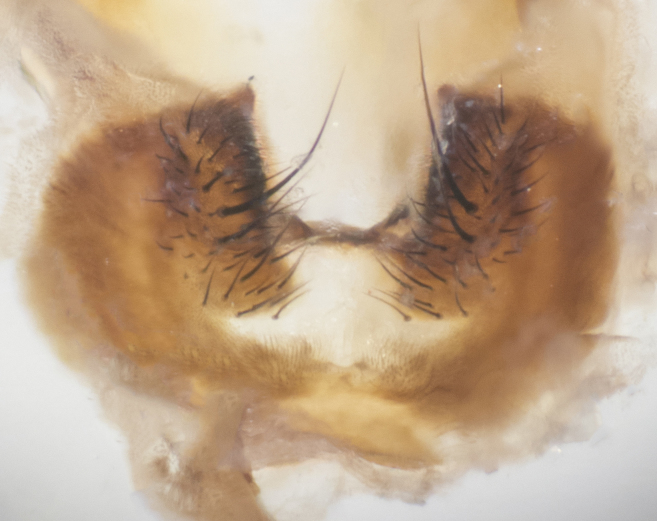
sternite 5, ventral view